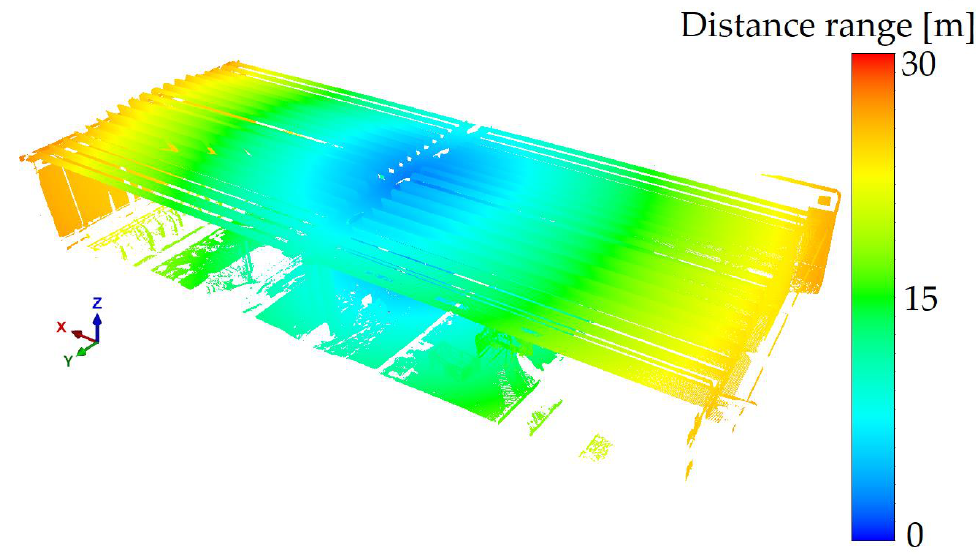
Figure 11. Distance range between scanner and concrete bridge.